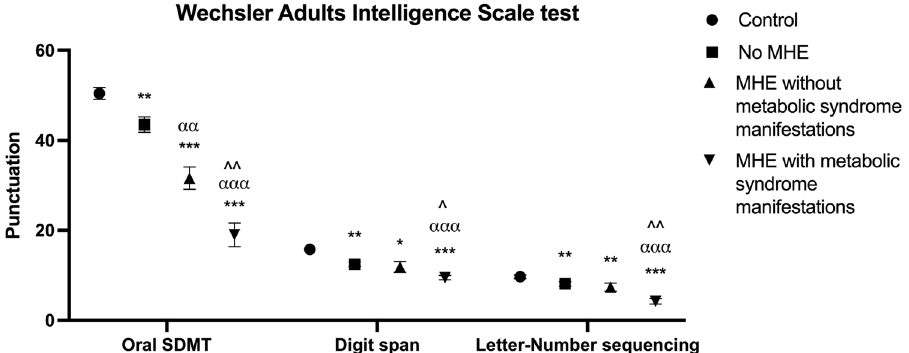
Figure 1. Performance of specific oral psychometric tests by controls, patients without MHE and patients with MHE according to presence of manifestations of metabolic syndrome at baseline. Oral SDMT: oral version of Symbol digit modalities test, expressed in correct pairings. Digit Span and Letter-Number sequencing test are expressed as right answers. Punctuation expressed as mean (SEM). *significant differences from controls (* p < 0.05; ** p < 0.01; *** p < 0.001). α significant differences from no MHE ( α p < 0.05; αα p < 0.01; ααα p < 0.001). ^significant differences from patients with MHE without metabolic syndrome manifestations (^ p < 0.05; ^^ p < 0.01; ^^^ p <